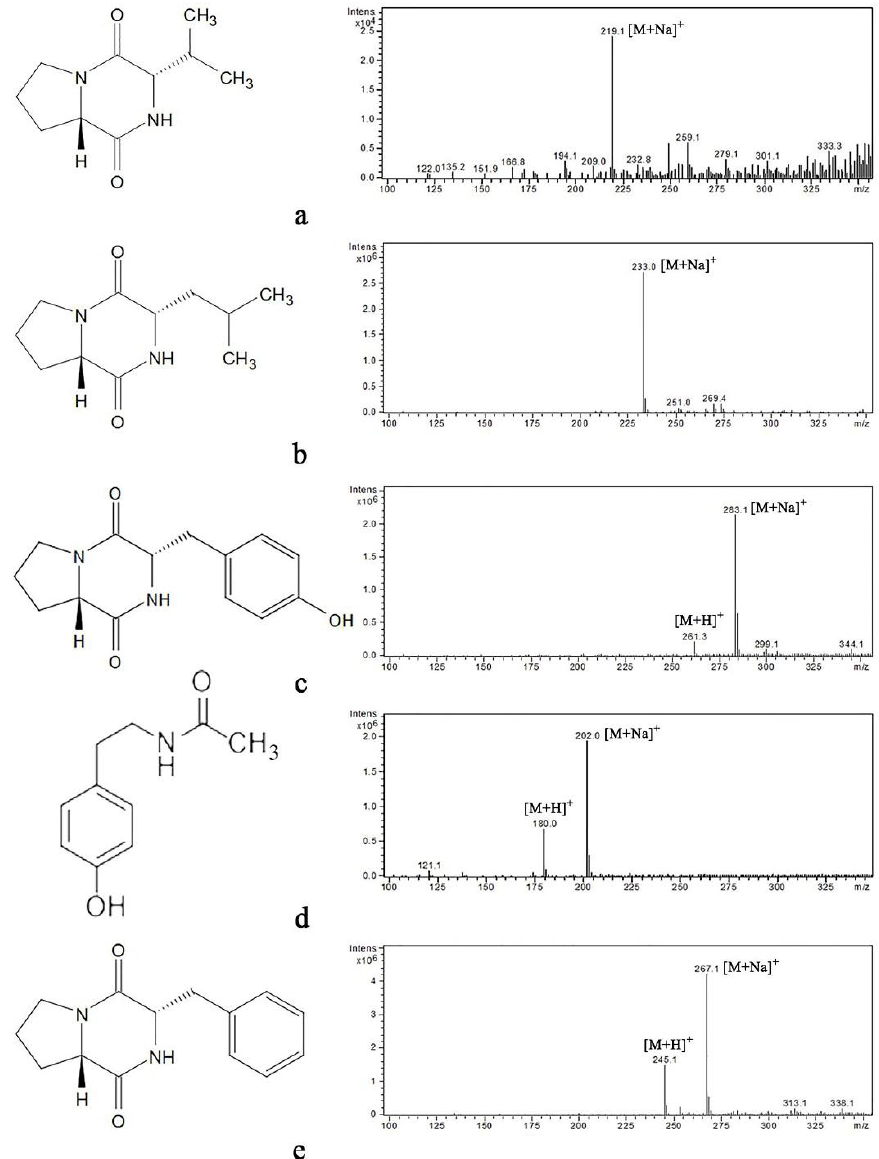
Compound 5: cyclo(L-Pro-L-Phe); white crystals; molecular formula: C 14 H 16 N 2 O 2 ; ESI-MS ( m/z ): 245.1 [M+H] + , 267.1 [M+Na] + . Compound 5 is consistent with a previous report [33] (shown in Supplementary Table S5). The structural formula and mass spectrum of compound 5 are shown in Figure 4e.